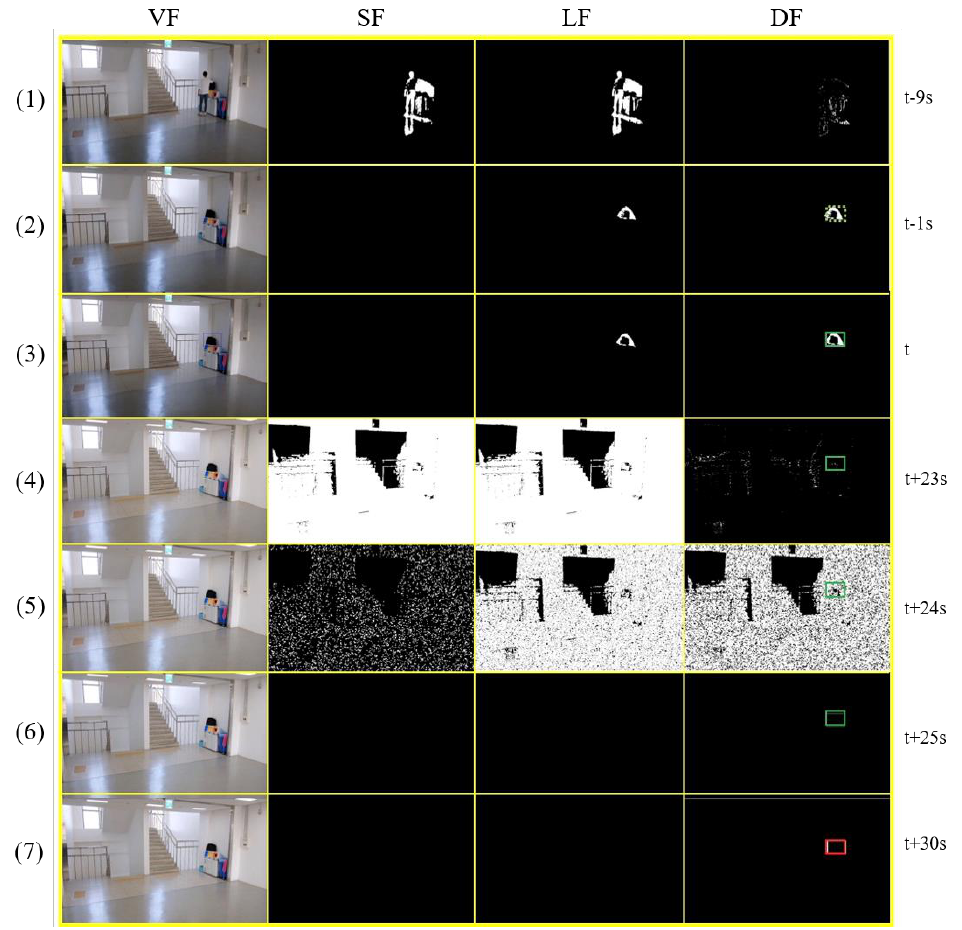
Figure 9. Indoor illumination changes in KICV video 2. Table 4. Comparison results using the color histogram and the largest contour in KCVI dataset.